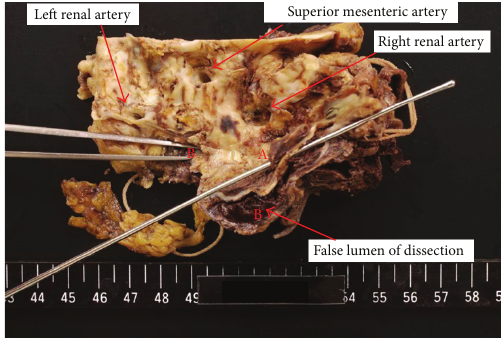
Figure 2: Specimen of the proximal neck after the stent graft was retrieved (view from the luminal side). (a) A tear communicating with the dissected lumen. (b) The false lumen of the